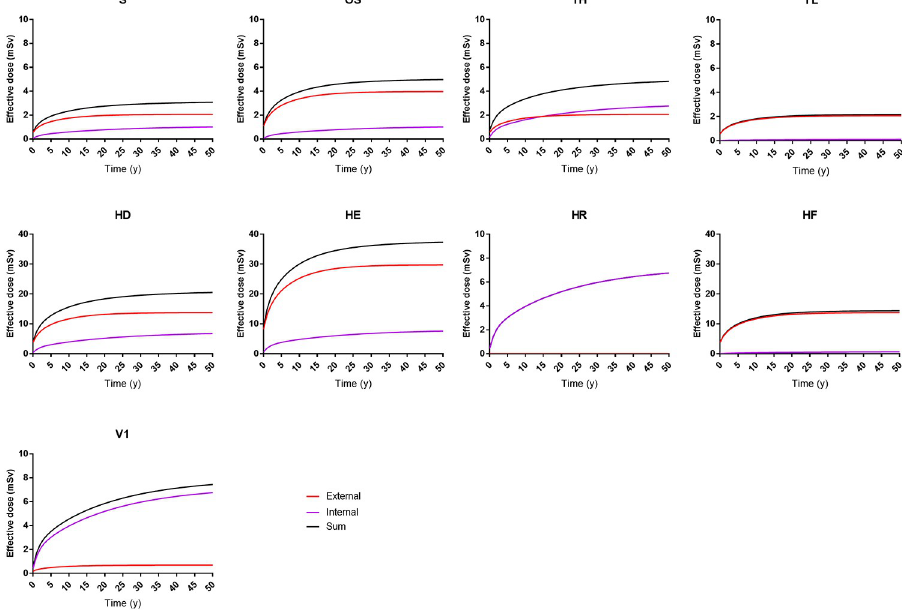
Fig 3. Cumulative effective dose (mSv) for adult males during 50 years, assuming the various scenarios described in Table 2. Note the varying scales on the dose axis.